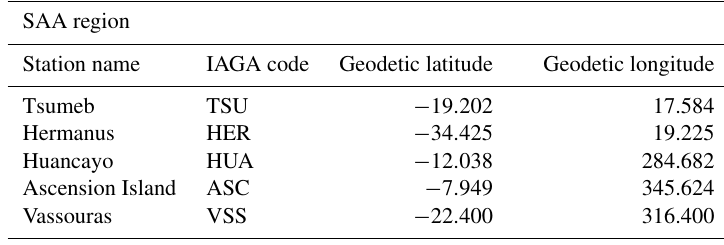
Table 1. Stations involved in the